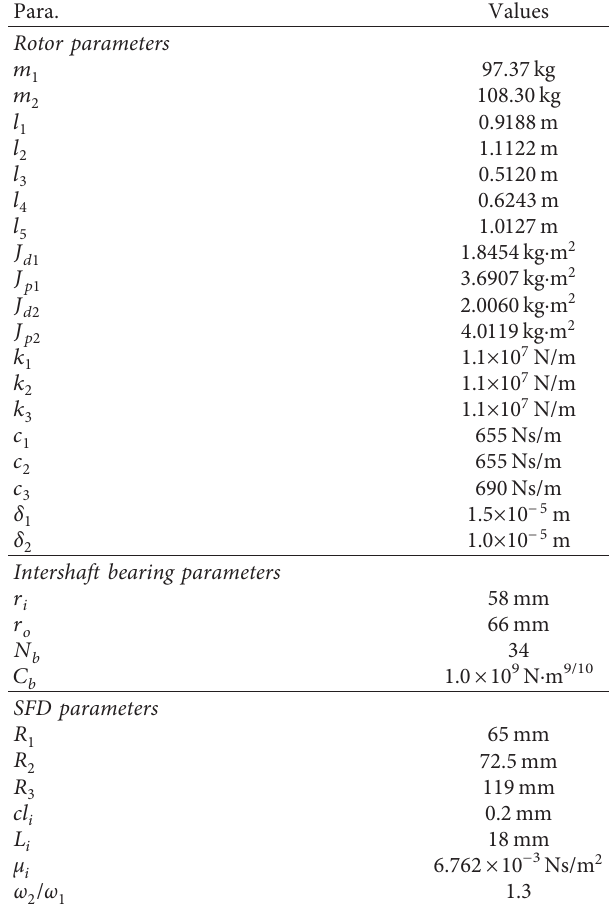
Table 1: The values of parameters used in the simulation.